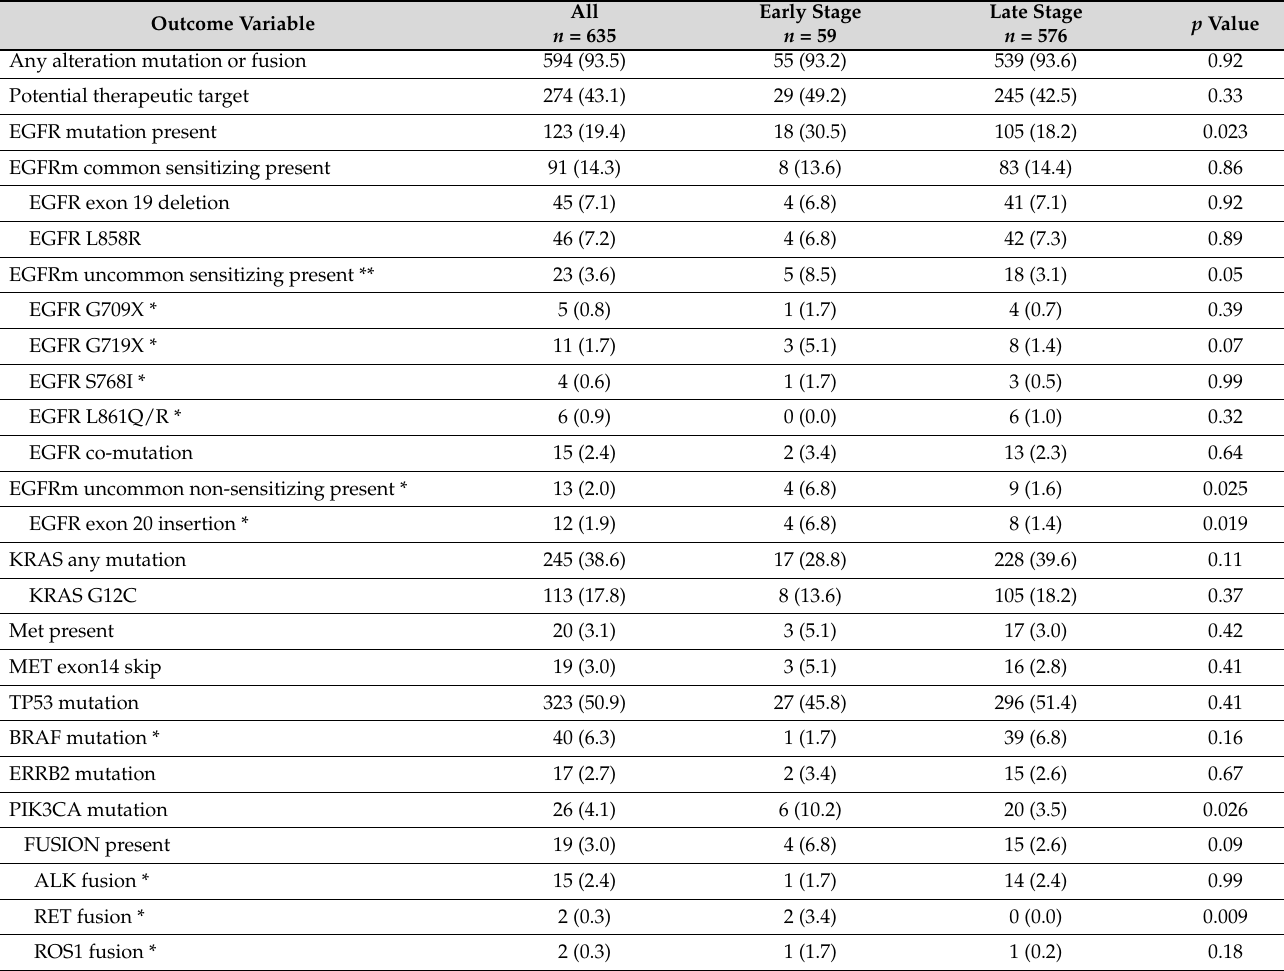
Table 3. Summary of outcomes among all